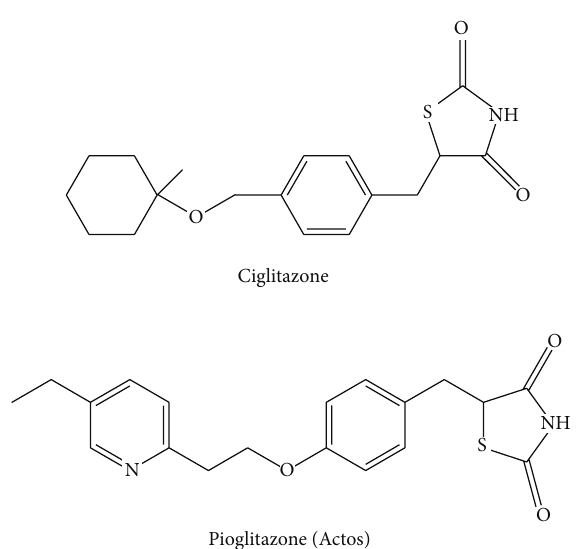
Figure 1: Structures of ciglitazone and pioglitazone [25].